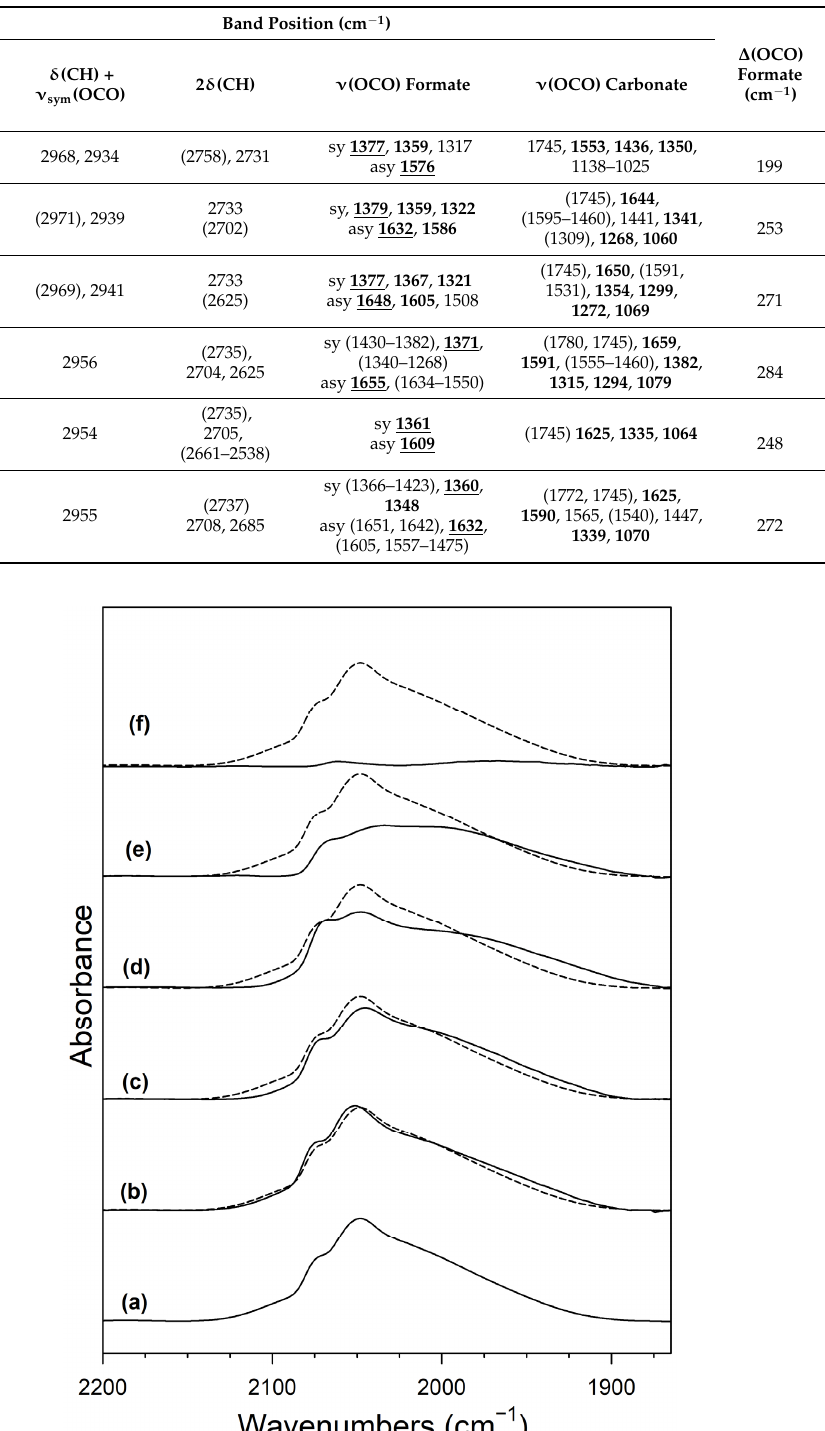
Table 2. Formate ν (CH) band region at the maximum intensity (125–175 ◦ C) and other relevant vibrational positions during temperature stepped formaldehyde/H 2 O reaction using the assignments of Binet et al. [33]. Carbonate band positions were recorded at 300 ◦ C.